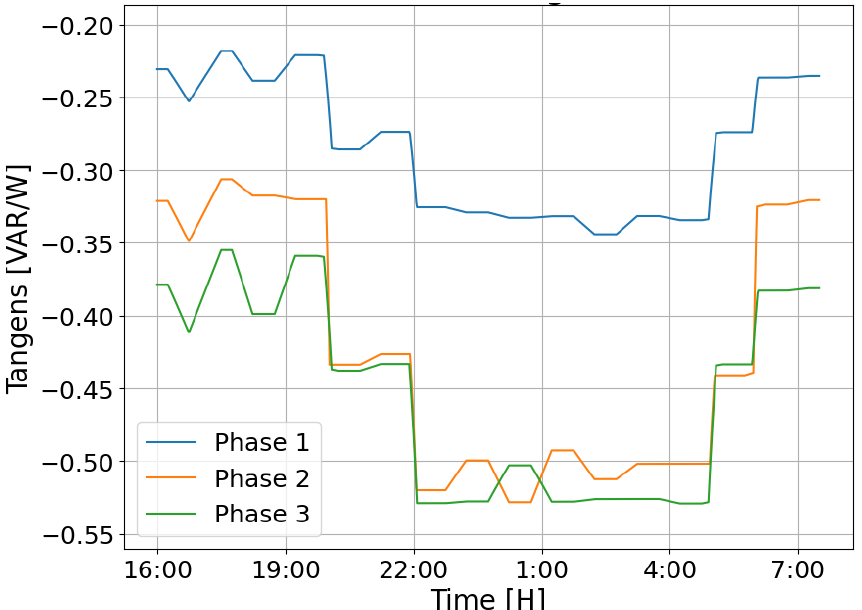
Figure 12. Characteristic of changes in the values of tan coefficients—luminaires with LED sources (without reduction). Source: own study.